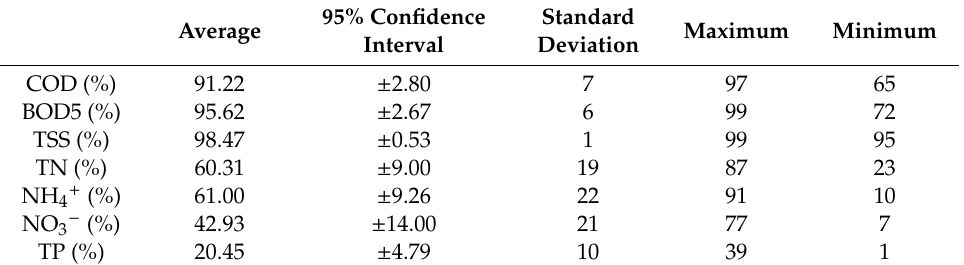
Table 5. Statistics of accumulated removal efficiencies for the horizontal flow constructed wetland (HFCW).